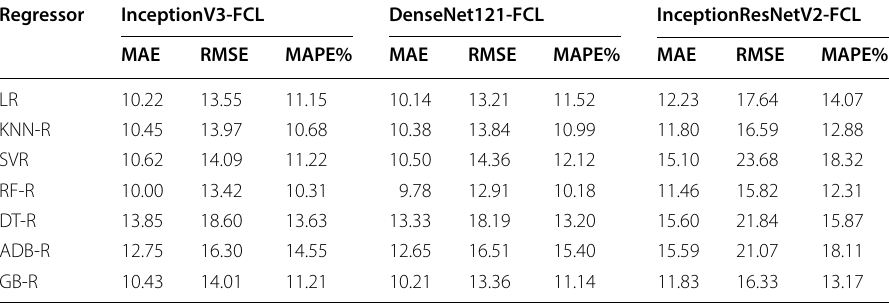
Table 3 Result of single Feature Connected Layer output (FCL) for RSNA dataset Regressor